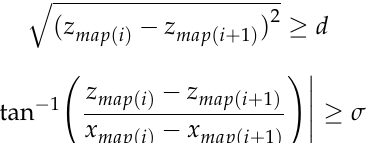
Figure 6. The 3D road map.